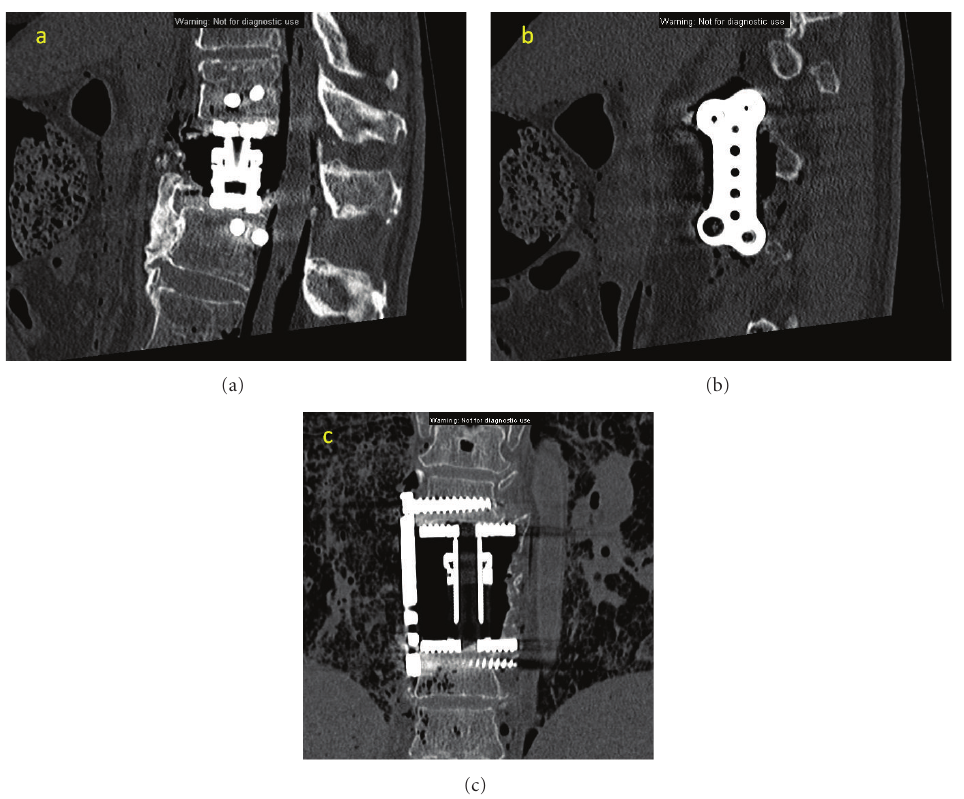
Figure 2: Cadaveric MIS lateral extracavitary corpectomy-coronal (a), and sagittal images of the plate (b) and cage (c) construct.